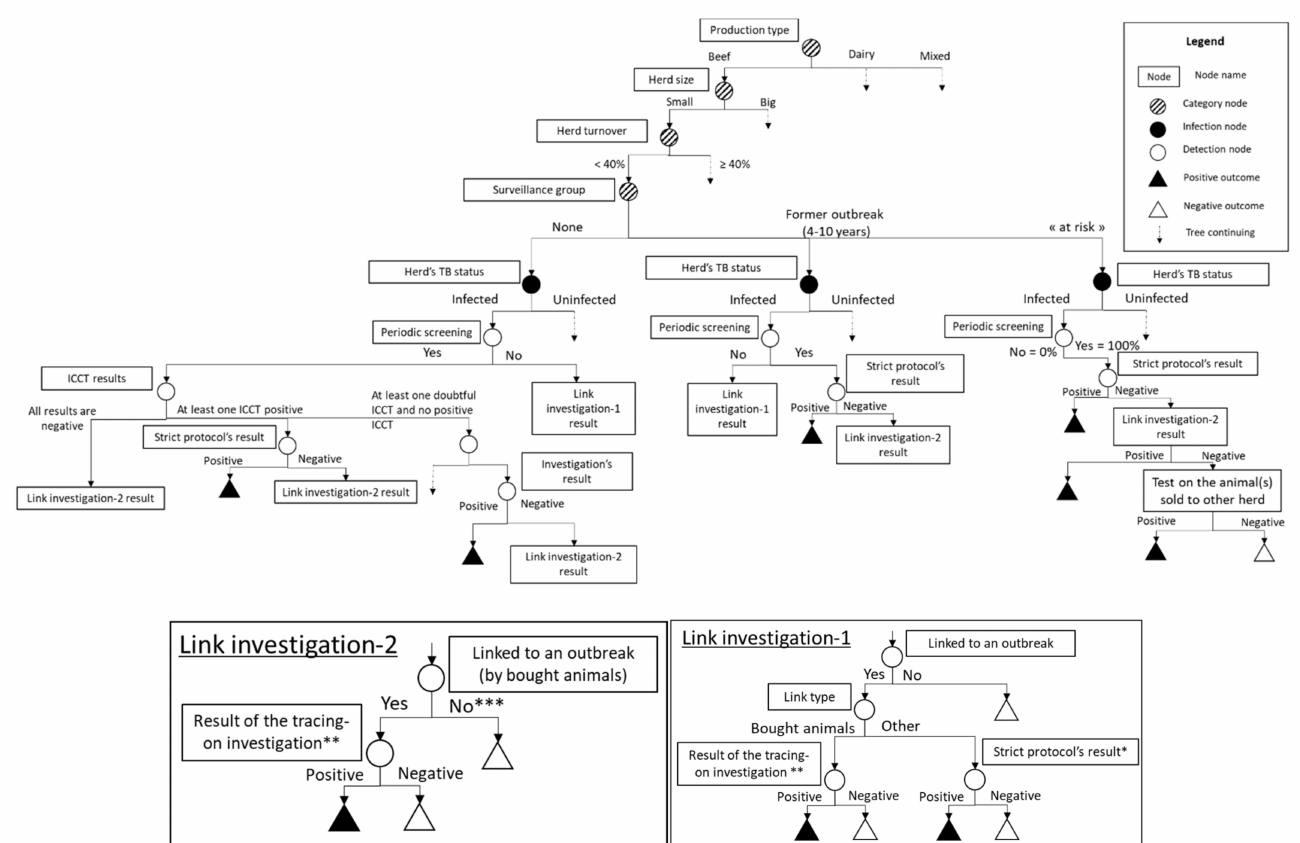
Figure 1. Scenario tree used to model the French ante-mortem TB surveillance and its various components. * Strict protocol = protocol to investigate TB suspicions following periodic screening with ICCT [4,6]. ** “trace and cull” protocol = tracing-on investigation protocol in which linked animals (= bovines bought from the outbreak) are systematically culled [5]. *** The herd is either not linked to any outbreak or linked by neighboring or by selling animals to the outbreak. In this last case, no further investigations are led because the herd had already been screened during periodic